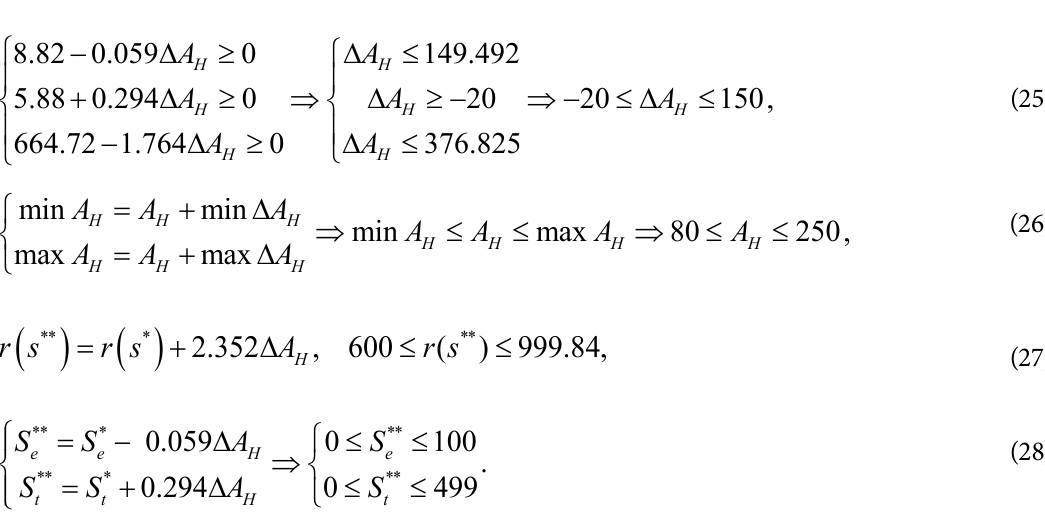
Table A5. Price variability for “wow-effect” tourism services (green tourism destination) Basic